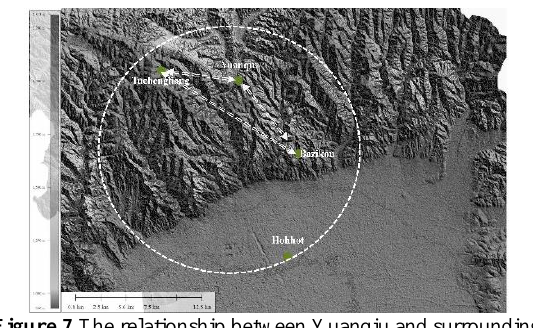
Figure 7. The relationship between Yuanqiu and surrounding towns.